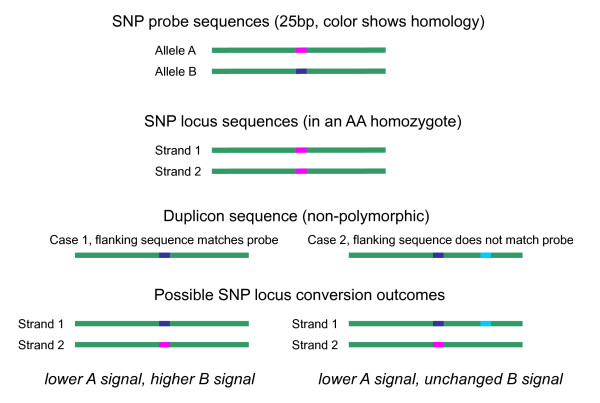
Effects of gene conversion on probe intensity signals. A microarray has two probes for a SNP, each 25 bp long (top). An individual with an AA homozygous genotype at the SNP locus is shown. Two examples of gene conversion are illustrated. The left example considers the case when the duplicon contains sequence that exactly matches the B probe. The right example considers the case when the duplicon contains sequence that does not match either probe.